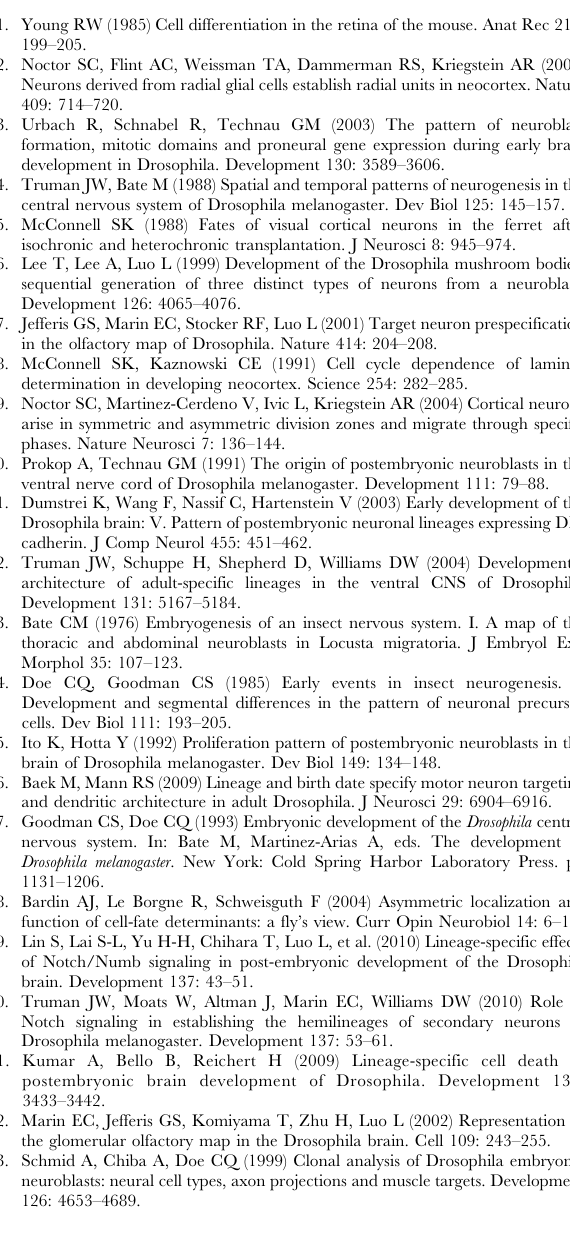
Table S5 Branch number of different adPN types in the MB